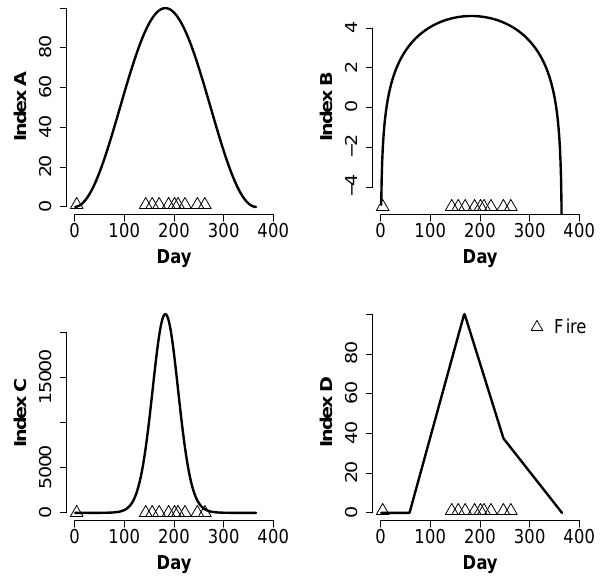
Fig. 2. Hypothetical fire danger index values over the course of one year. Index A is sinusoidal, as defined in Eq. (5) (in text). Indices B and C are respectively logarithmic and exponential transformations of index A, and index D is a discontinuous function described in Equation set 6 (in text). Triangles indicate fire occurrence days.